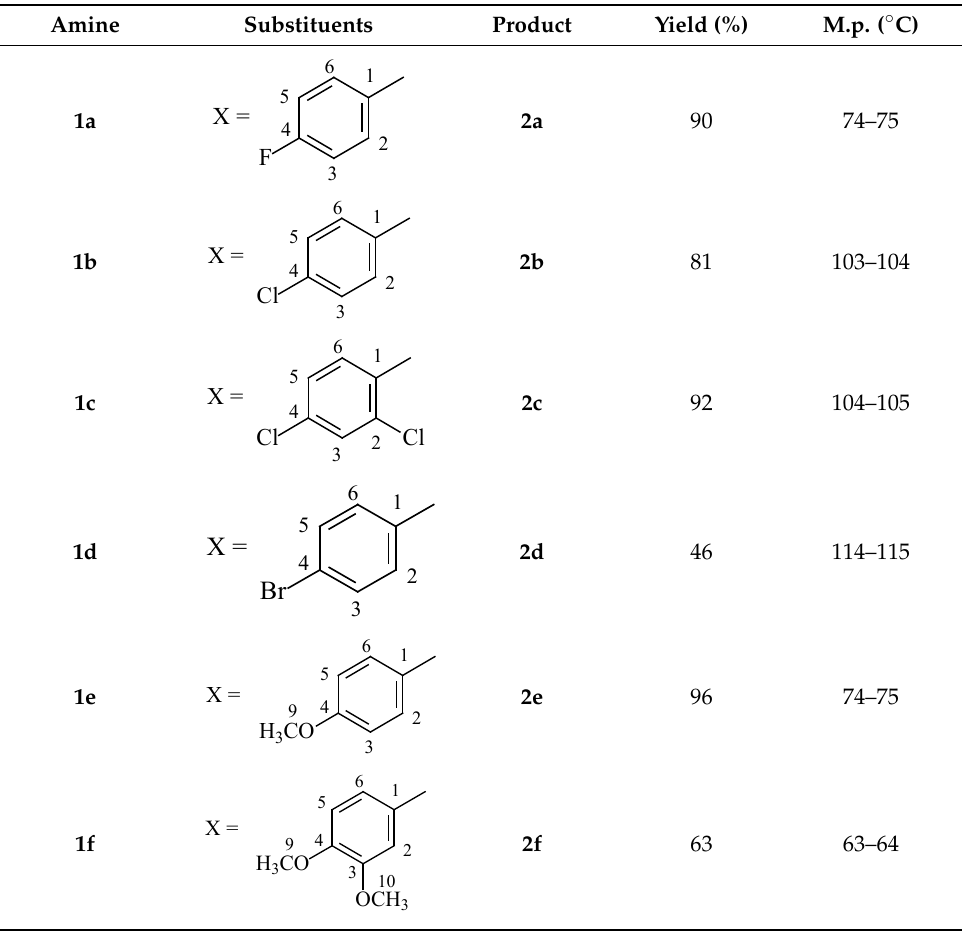
Table 1. Amines ( 1a – 1f ) used in synthesis followed by yields and melting points of respective N -(2-